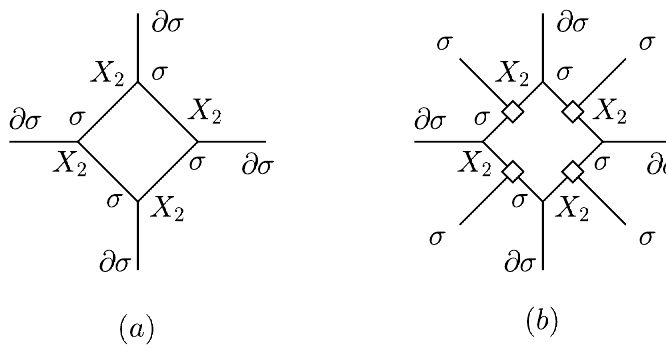
Figure 3 . The most UV divergent one-loop σ -amplitudes in the X -theory formulation of the scalar